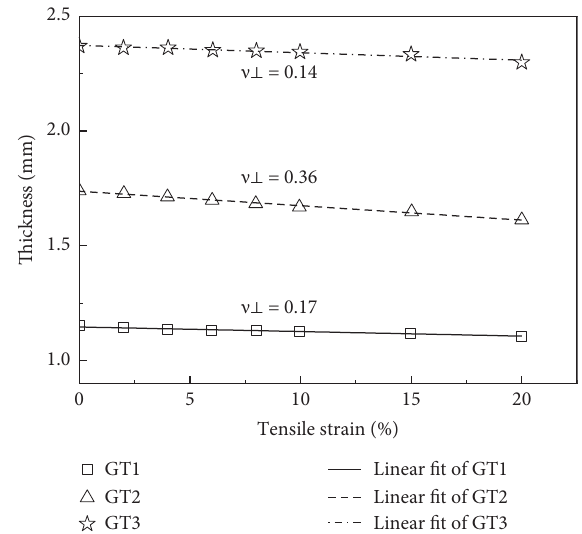
Figure 1: Variations in geotextile thickness with tensile strains (data sourced from reference